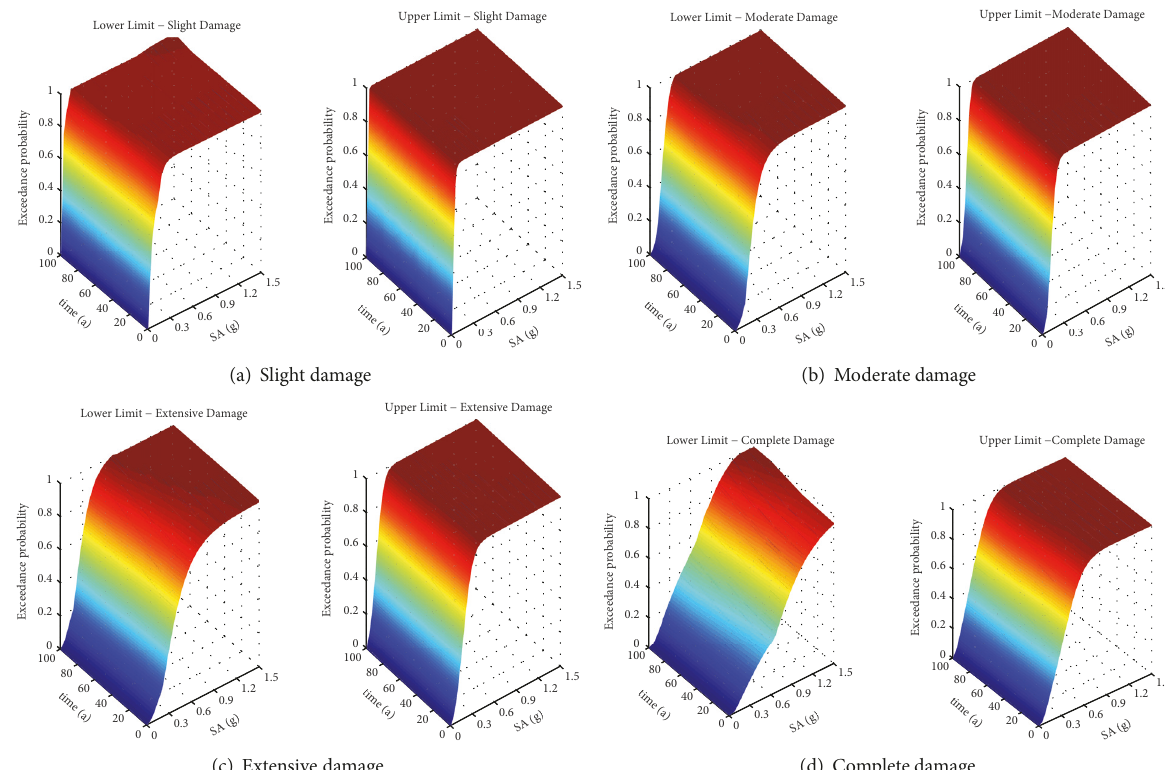
Figure 22: The vulnerability surfaces of bridge system under different